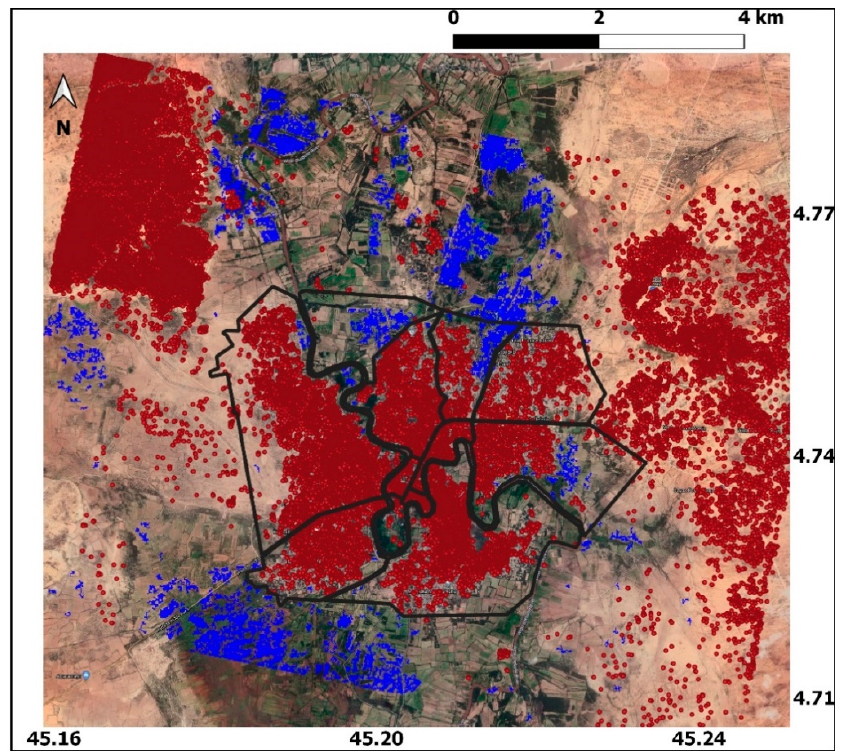
Figure 2. Rural/suburban areas classified as flooded on 26 April, 2018 by the algorithm developed in [4] (blue) and persistent scatterers (red dots) identified in the Beletweyne area. The boundaries of the districts shown in Figure 1 are highlighted in